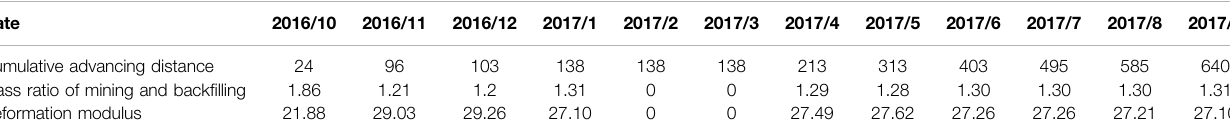
TABLE 4 | Mass ratio of mining and back fi lling and deformation modulus data in coal